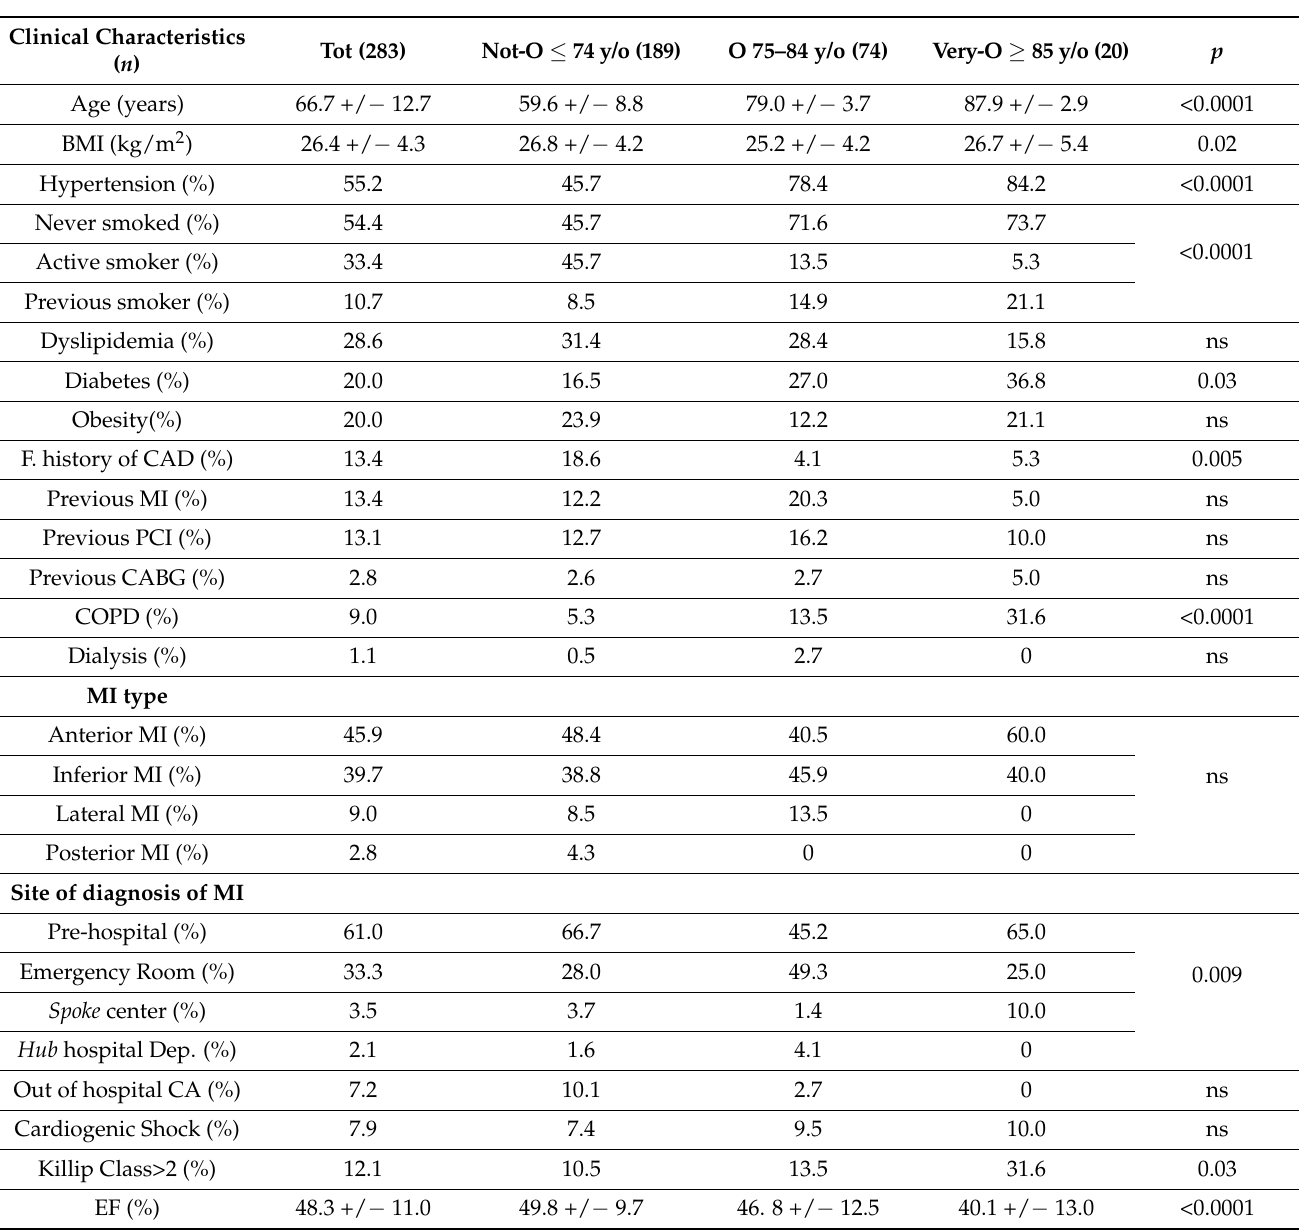
Table 1. Clinical